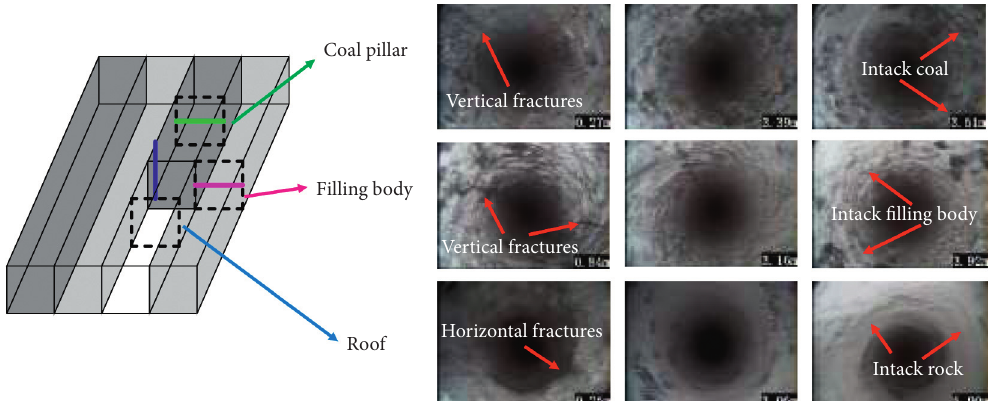
Figure 14: Borehole